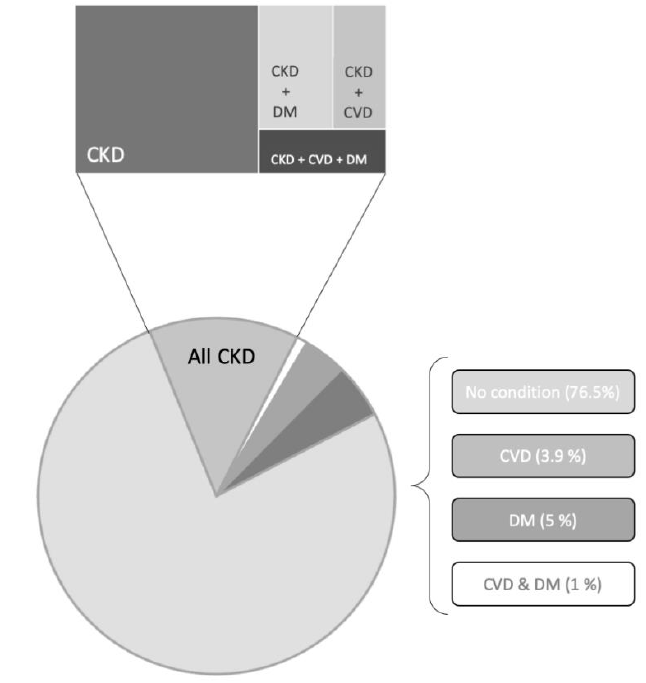
Figure 1. Prevalence of Chronic Kidney Disease (CKD) and other associated and underlying diseases in the United States of America. Data are from the National Institute of Diabetes and Digestive and Kidney Disease—U.S. Department of Health and Human Services [modified from: [5]. In the pie graph CKD accounts for 13.6 % of the total area. CKD; chronic kidney disease. DM; diabetes mellitus. CVD; cardiovascular disease.